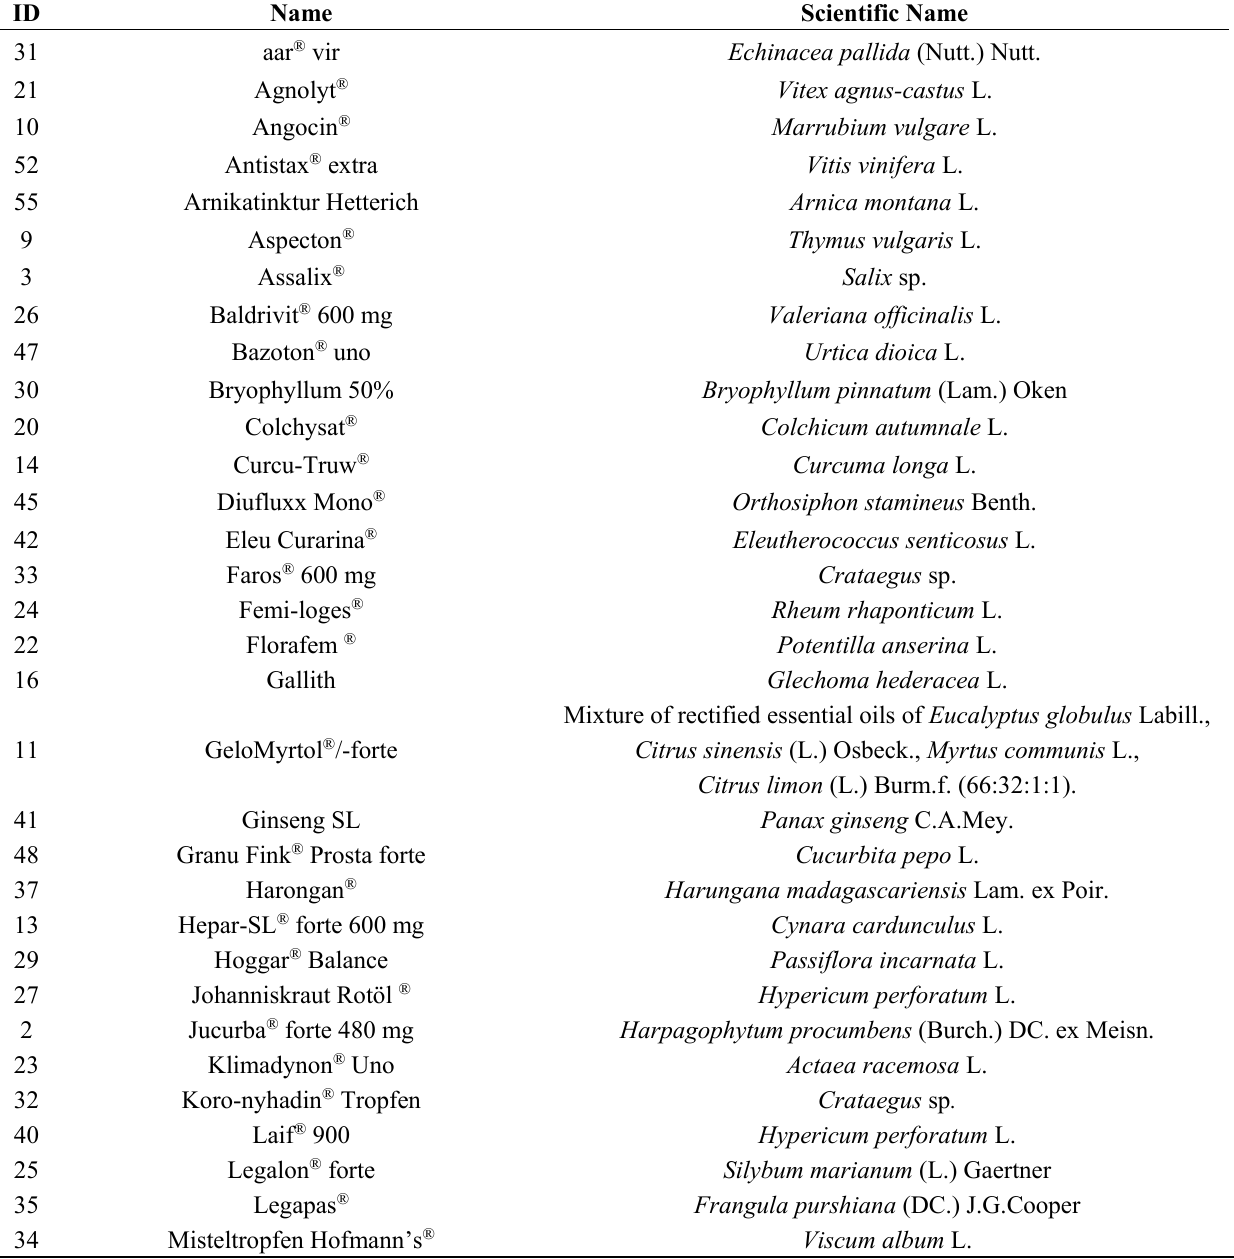
Table A1. Complete dataset of the selected